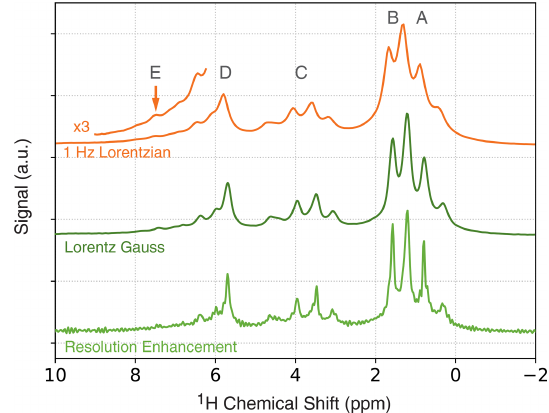
Figure 3. One-dimensional ODNP-enhanced NMR spectra (128 averages) of ethyl crotonate with 10mM TEMPONE using different apodization functions. Top: 1Hz Lorentzian line broadening. Mid- dle: Lorentz–Gauss transformation using 4Hz line broadening for both Gaussian and Lorentzian linewidths. Bottom: resolution en- hancement after Traficante and Nemeth (1987) and Traficante and Rajabzadeh (2000) using T ∗ of 2